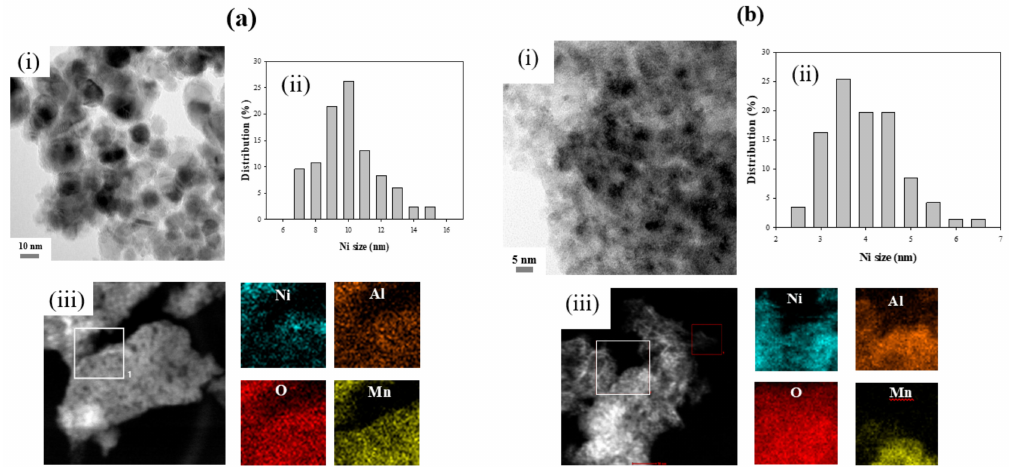
Figure 4. (i) High-resolution transmission electron microscopy (HRTEM) image, (ii) Ni particle size distribution, and (iii) elemental mapping for ( a ) reduced Ni / Al@MnAl 2 O 4 (WI) and ( b ) reduced Ni / Al@MnAl 2 O 4